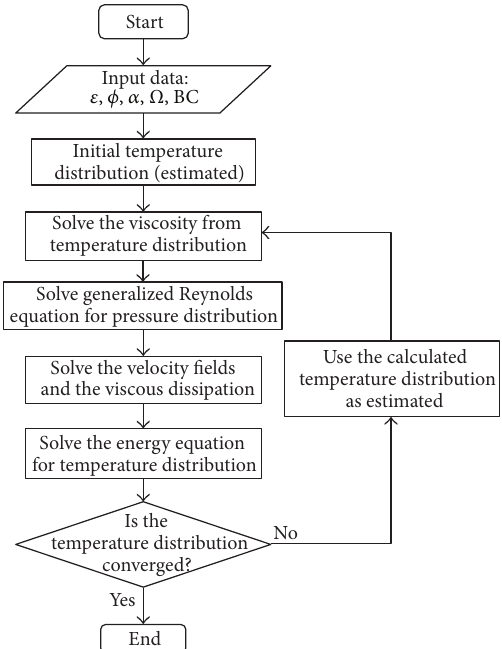
Figure 9: General flowchart of the routine for thermohydrodynamic analyses.